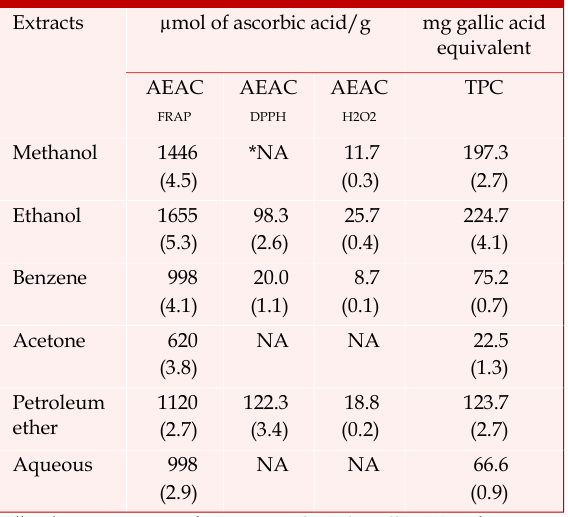
Anti-oxidant activity of different extracts of P. hab-